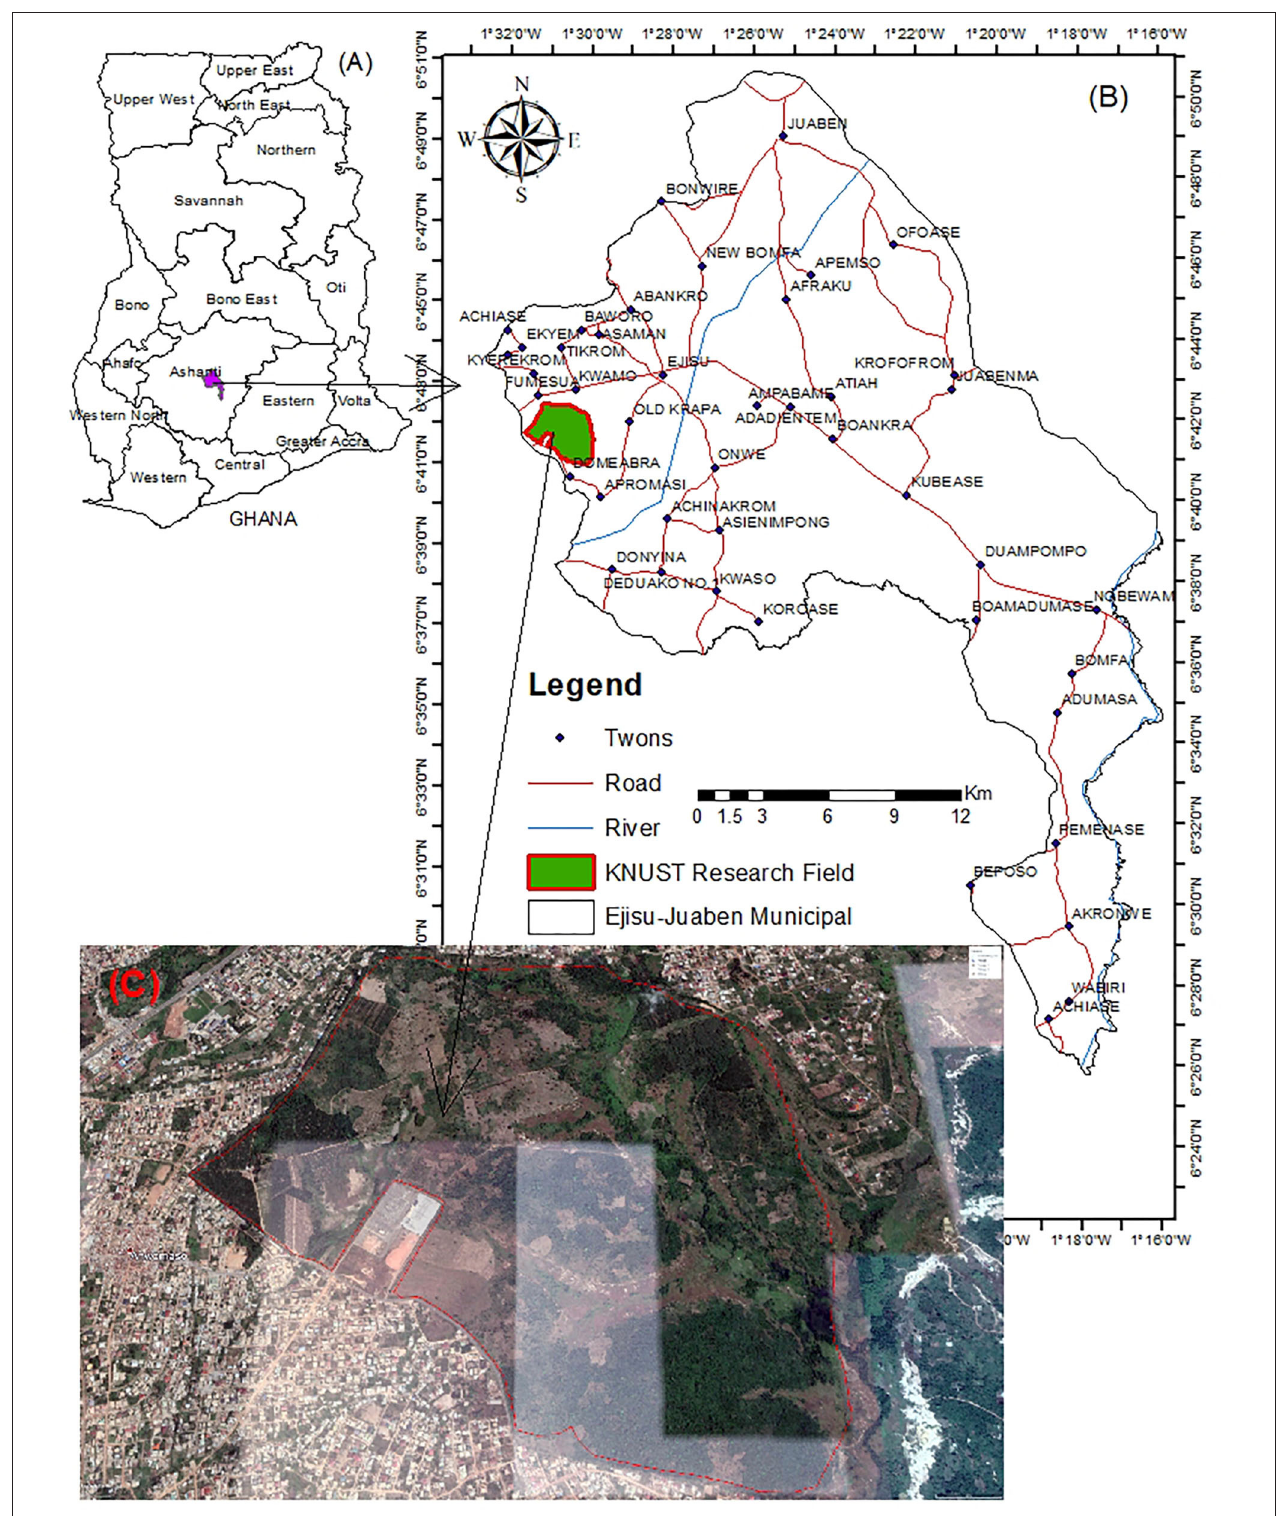
FIGURE 1 | Map of the study site showing (A) regions in Ghana, (B) Ejisu Municipality, and (C) KNUST Research Field at Anwomaso from Google Earth Image on 21 May 2021.